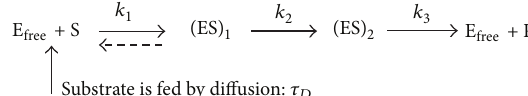
Figure 4: Chemical kinetic mechanism of a hypothetical enzymatic reaction where substrate is fed by diffusion. Two transient states, enzyme-substrate complexes (ES) 1 and (ES) 2 are successively popu- lated until the free enzyme is released. The dashed arrow denotes a potential equilibrium that is ignored